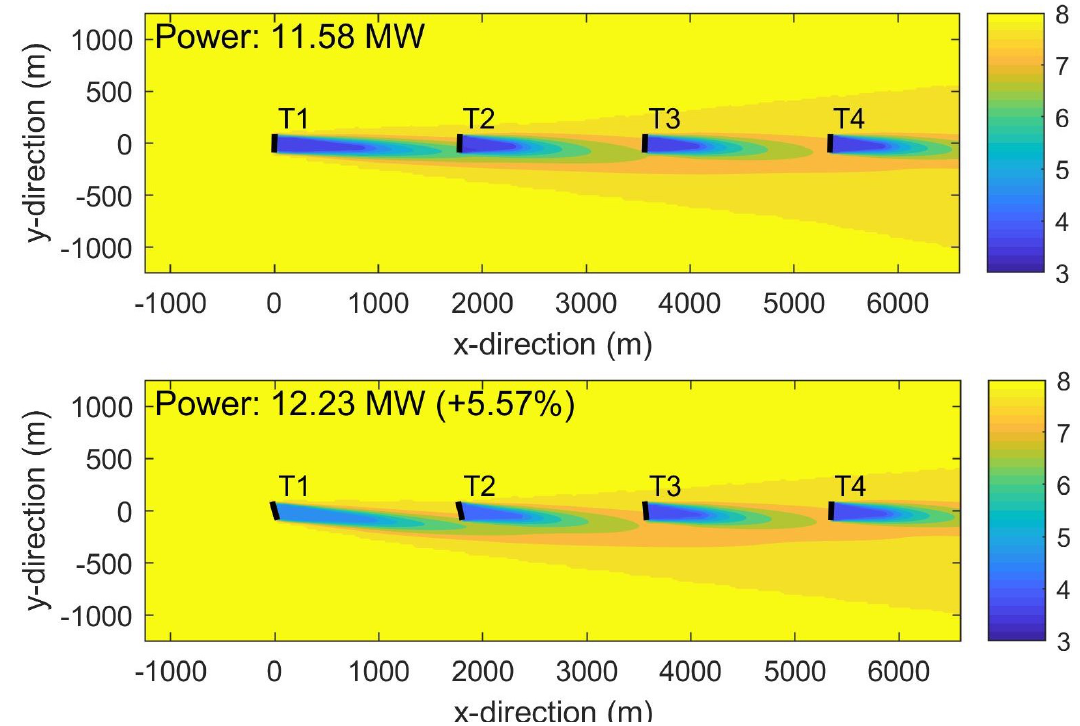
Figure 1. Illustration of the wakes through a row of four turbines spaced at 10D: ( top ) nominal operation without AWC. ( bottom ) operation with AWC by wake